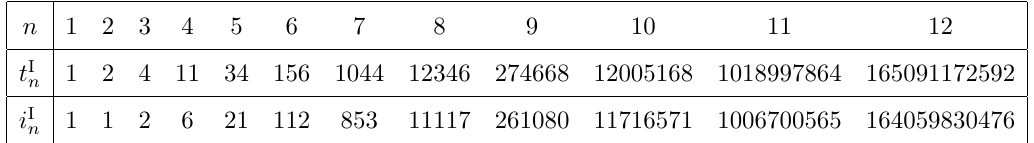
(number of graph isomorphism equivalence n . Integer sequences A000088 n